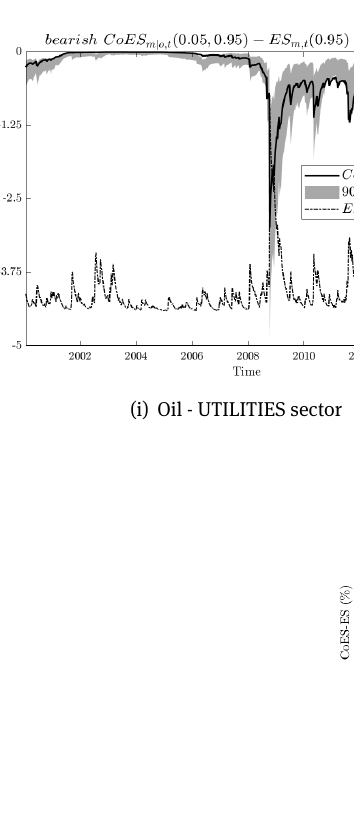
Figure 19c: CoES m | o , t (0.05, 0.05) for a certain sector given a bearish scenario for oil